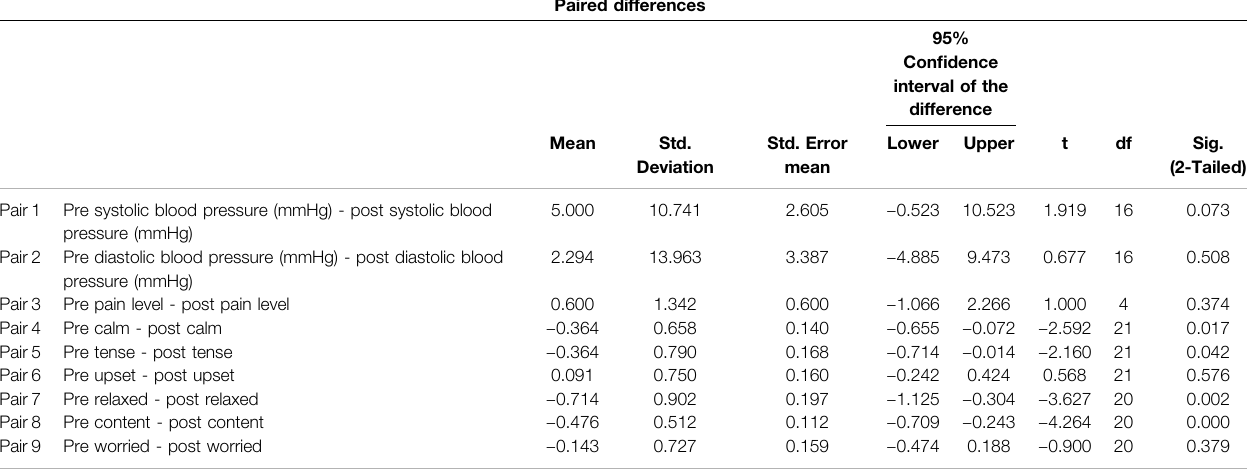
TABLE 5 | Paired sample T-test, pre- and postintervention (virtual reality).